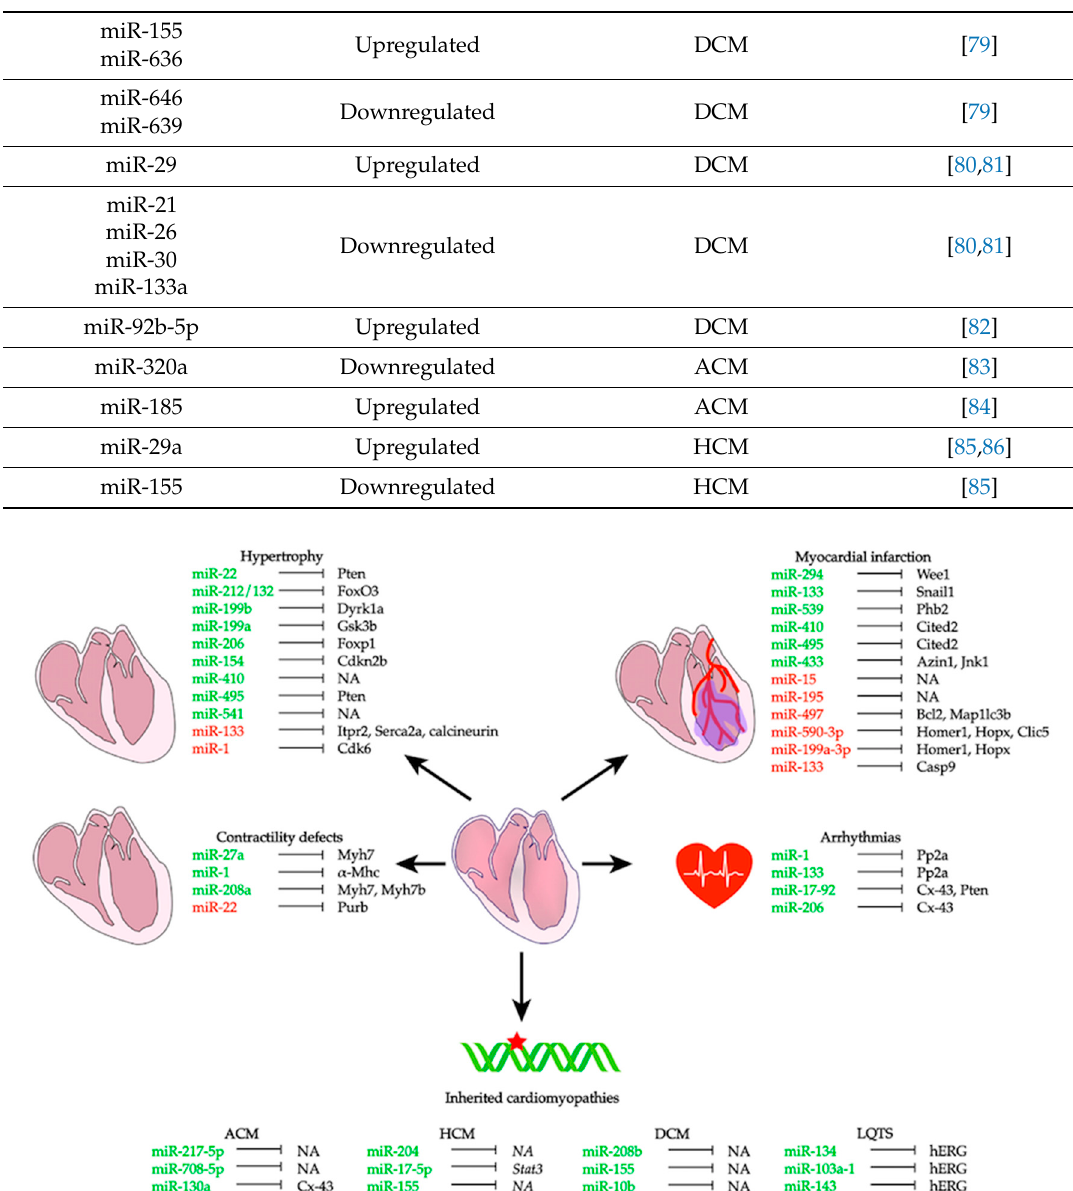
Figure 3. Circulating miRNAs are associated with different cardiac diseases. Green miRNAs are upregulated, while red miRNAs are downregulated in the different diseases. 2. Contractility Defects Cardiac contractility consists of the fast and unidirectional development of mechanical force and motion, determined by a highly ordered organization of sarcomeric proteins. The progressive